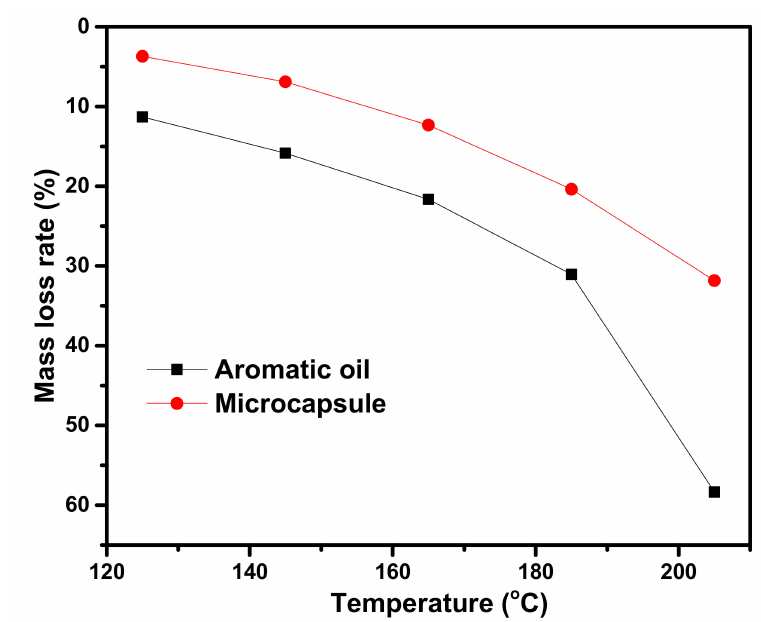
Figure 6. The mass loss rate of aromatic oil and aromatic oil microcapsules at different